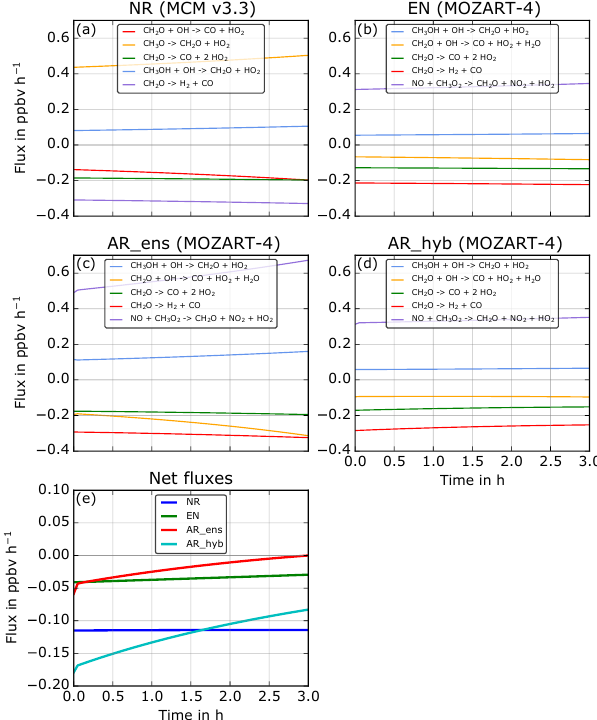
Figure 9. CH 2 O fluxes during the 3h forecast of the ninth cycle of the CH 2 O assimilation with no localization. For the NR (a) , one member of the CR (b) , one member of the AR ensemble (c) , and one member of the AR hybrid (d) . Net fluxes for each run are shown in panel (e) . Displayed are fluxes representative of 90% of the